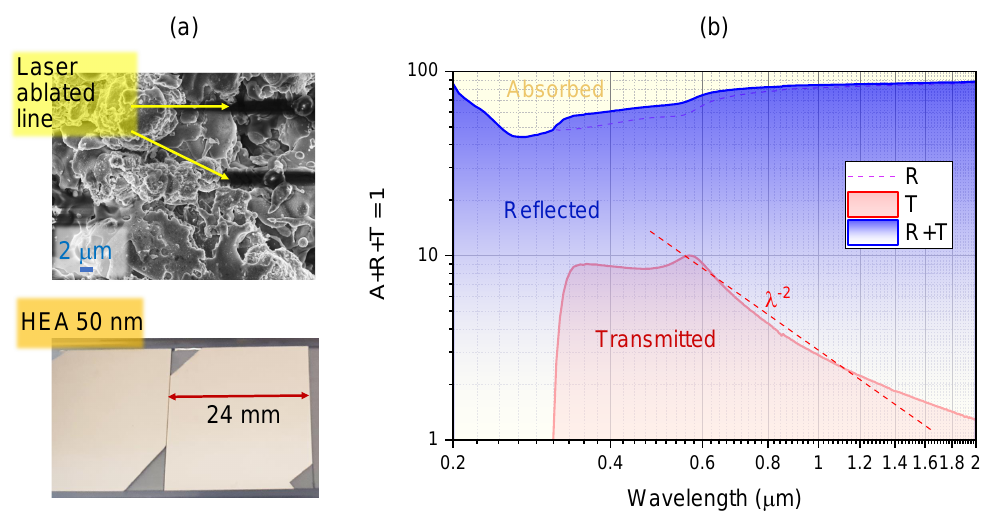
Figure 1. ( a ) SEM image of CoCrFeNiMo 0.2 HEA surface ( ∼ 100 µ m film on Cu-backing plate) with laser ablation trenches. The laser focus was ∼ 1.22 λ / NA ≈ 2.4 µ m for λ = 515 nm laser wavelength and NA = 0.26 objective lens. Photos of HTA ∼ 50 nm film sputtered on cover glass No. 4 ∼ 0.5 mm (Matsunami). Magnetron sputtering was carried at an RF bias power of 100 W rate, 7.5 nm/min deposition rate, and 10 − 5 atmospheric pressure (Axxis, JKLesker). ( b ) Color- coded portions of absorbed, A , transmitted, T , and reflected, R , light through the 50-nm-thick sputtered CoCrFeNiMo 0.2 HEA film. R , T were directly measured by using Spectrometer (Lambda 1050 UV/VIS/NIR, PerkinElmer); note the logarithmic ordinates